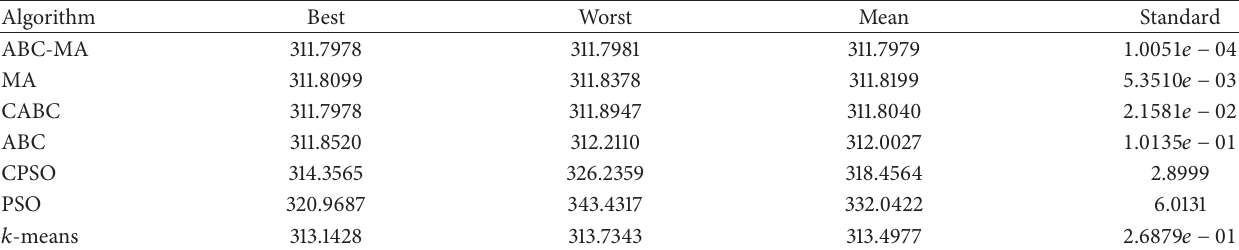
Table 6: Results obtained by the algorithms for 20 different runs on seeds data.